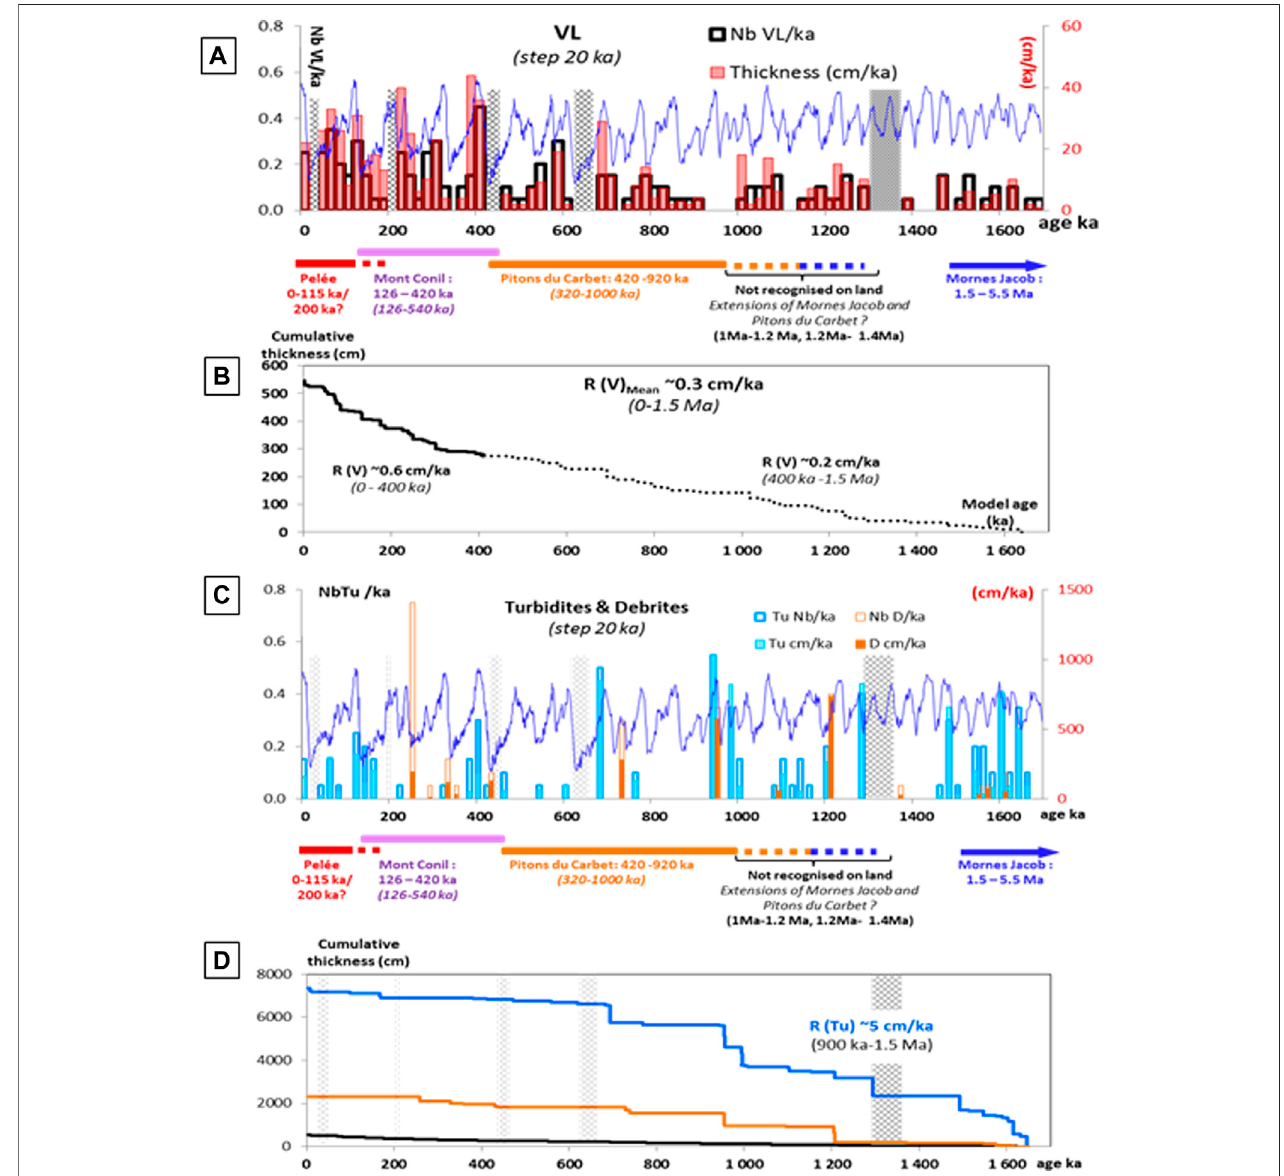
FIGURE 13 | Deposition rates of tephra and turbidites over the period 0 – 1.5 Ma (core U1399A). Histograms are drawn with intervals of 20 ka. Blue lines: LR04 curvesforcomparison ofdepositionratevariationswithhighand lowstandsofthesealevel.Dashedzones represent sedimentlack(lightgray)and void(darkgray)inthe core.Theheight ofthebars relates totherelative thicknesses ofthedeposits. Age ranges: thisstudy; inbrackets: previousdata(K-Ar dating; Germaet al.,2010;Germa et al., 2011a). (A) Tephra deposition rates. Nb VL/ka: total number oftephralayers (VL) per ka; VL thickness: total thickness of tephra layers per ka. (B) Cumulative thicknessesoftephra.R(V):meandepositionratesoftephraincentimeterperka.Inbrackets:intervalsoftimeforeachestimate. (C) Turbiditedepositionrates.Bluebars: turbidites;orange bars: debrites. Tu Nb/ka andD Nb/ka: total number ofturbidites and debrites per ka;Tucm/ka andD cm/ka: totalthickness ofturbiditesand debrites per ka. (D) Cumulative thicknesses of turbidites, debrites, and tephra. Blue line: turbidites; orange line: debrites. R(Tu): mean deposition rate of turbidites in centimeter per ka. In brackets: intervals of time for the estimate.